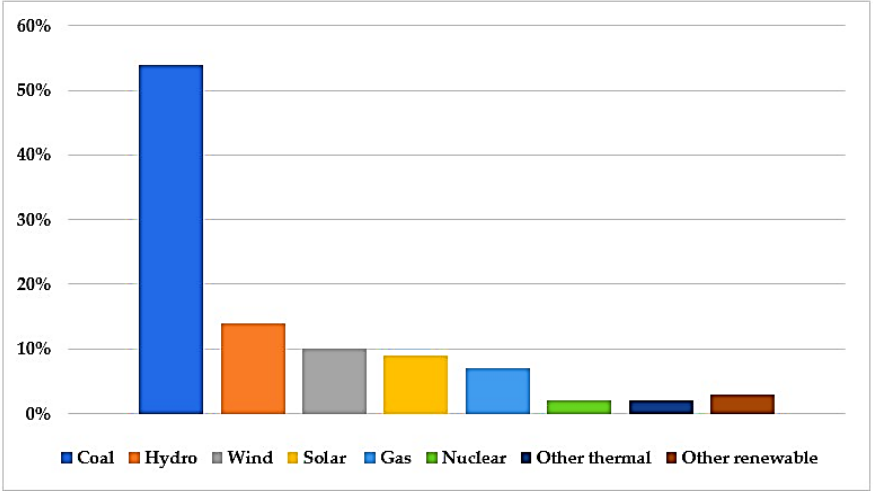
Figure 1. Total generating capacity of India in MW [7].